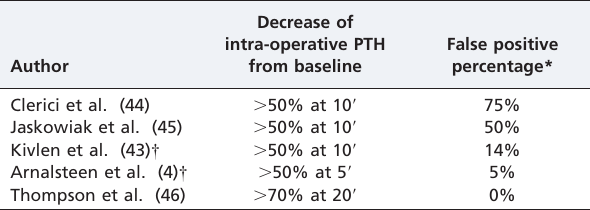
Table 3 - Intraoperative parathyroid hormone (PTH) monitoring for prediction of multi-glandular parathyroid disease after removal of the first pathological parathyroid